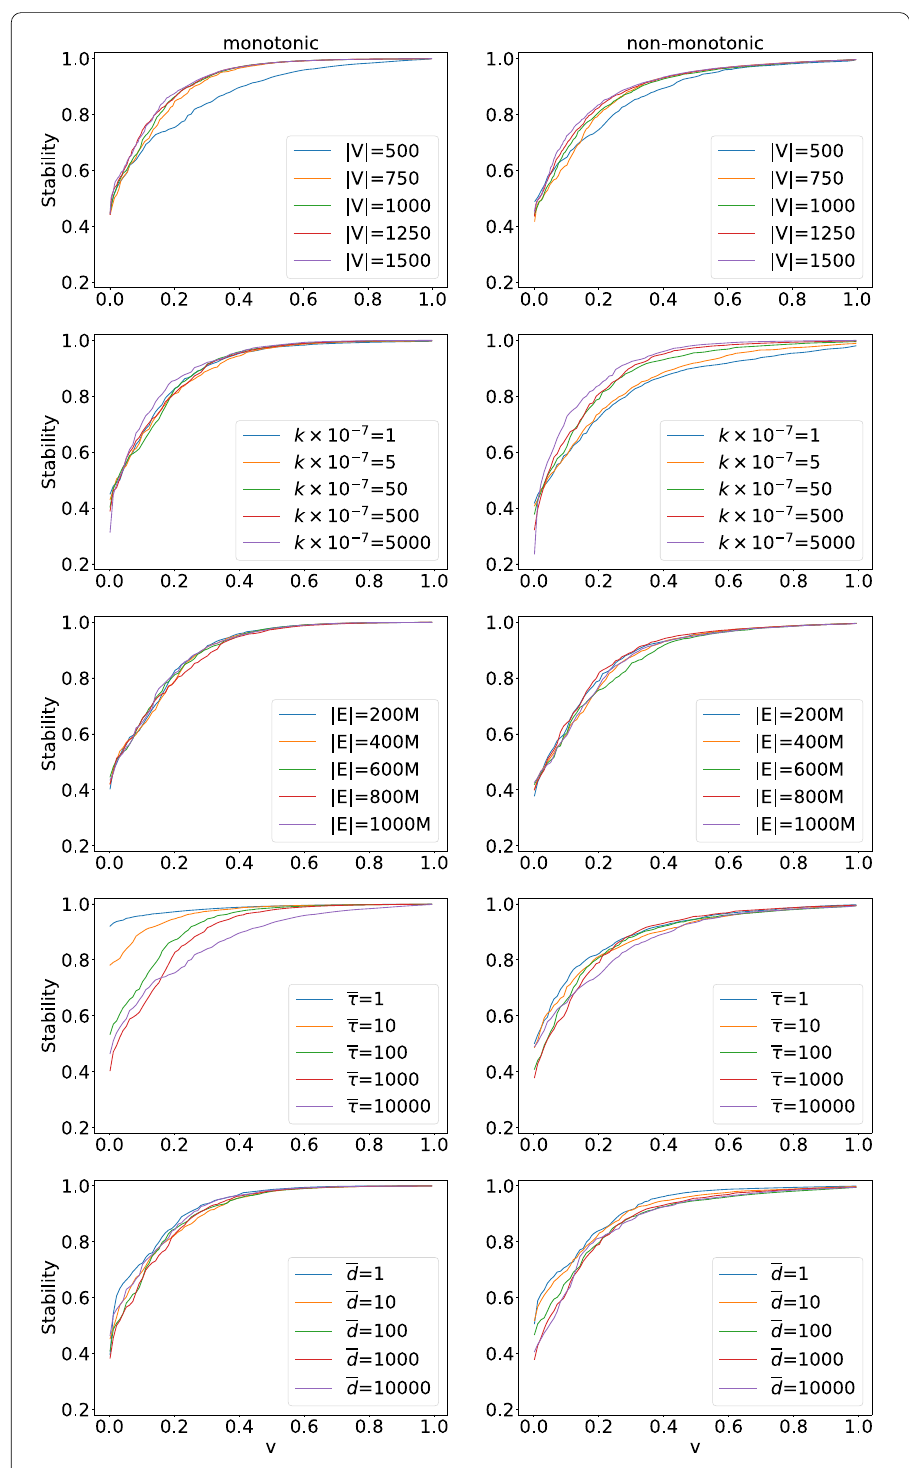
Figure 13 The node stability in various networks. We note that (1) higher | V | , k tend to lift the curve; and, (2) higher τ , d tend to pull down the